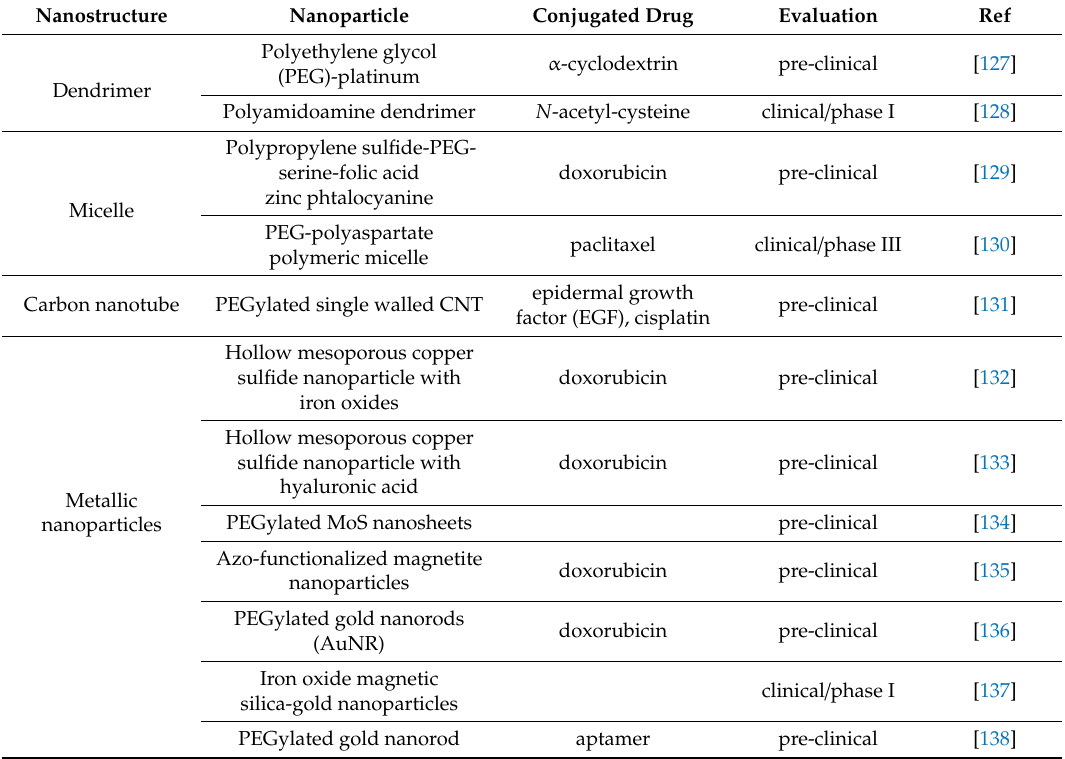
Table 2. Therapeutic nanoparticles under pre-clinical or clinical